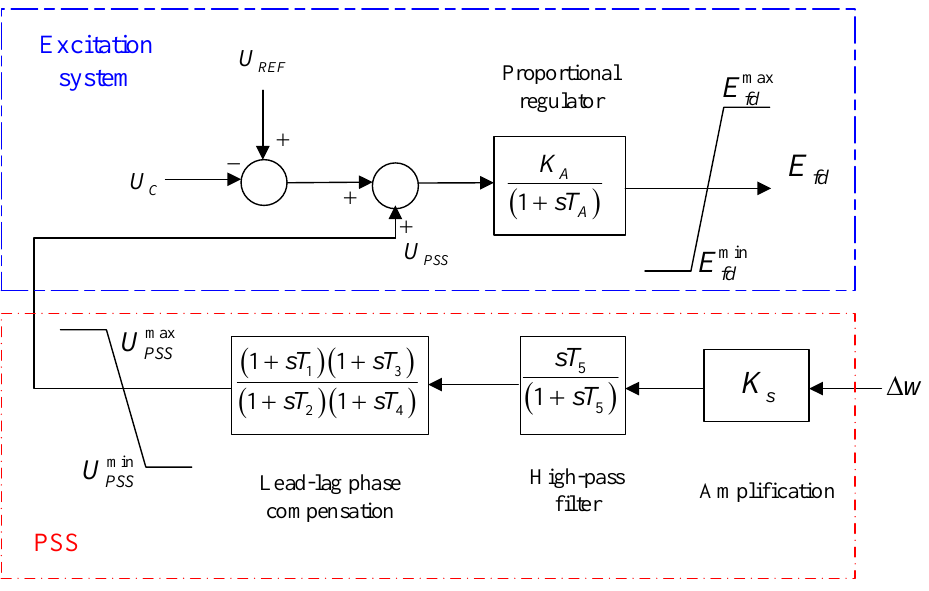
Figure 1. Excitation system with traditional lead-lag compensation type PSS. K PSS plays an effective role mainly by adjusting s and the inertia time constant of lead-lag compensators, and the other parameters for a generator are usually